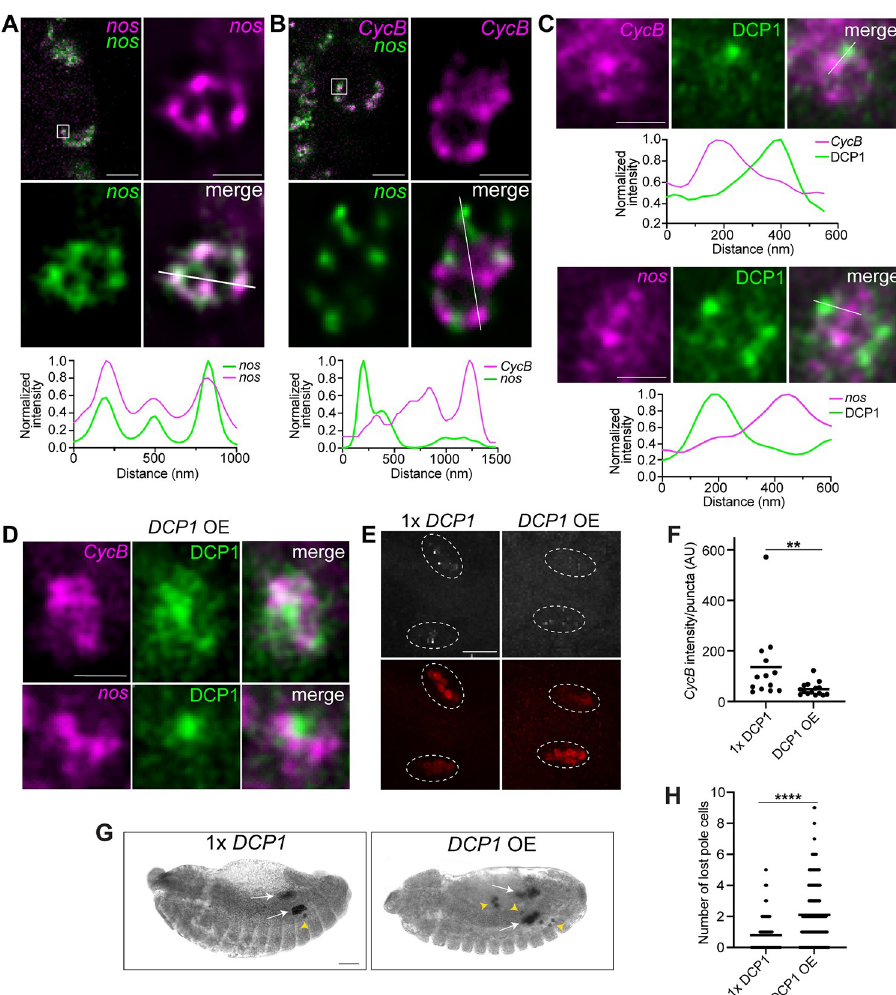
Fig 5. DCP1 localizes to puncta within germ granules that do not overlap with CycB or nos . (A, B) The 2D STED images of individual germ granules (indicated by the white box on the confocal section shown in the upper left panels) from a pole cell at nc13 or 14: nos was detected using 2 different smFISH probe sets (green + magenta) in (A); nos (green) and CycB (magenta) were detected by smFISH in (B). Fluorescence intensity was measured along the path marked with a white line and intensity profiles of each channel, normalized to the maximum value, are plotted. (C) The 2D STED images of individual germ granules showing the distribution of DCP1 (green) relative to nos or CycB (magenta) in wild-type embryos. Fluorescence intensity profiles along the path indicated by the white lines are shown. (D) The 2D STED images of individual germ granules showing the distribution of DCP1 (green) relative to nos or CycB (magenta) in embryos overexpressing DCP1-smg3 0 UTR . In all images, DCP1 was detected by immunofluorescence. STED images were deconvolved using NIS-Elements software and the brightness and contrast were adjusted individually for each image in order to best show the distributions of the mRNAs or protein at that stage. (E) Maximum intensity confocal z-projections of CycB detected by smFISH (white), and Vas detected by anti-Vas immunofluorescence (red) in the gonads of embryos heterozygous for a DCP1 mutation (1 × DCP1 ) and DCP1-smg3 0 UTR overexpression ( DCP1 OE) embryos. White circles outline the regions of the gonads. (F) The average fluorescence intensity of CycB puncta per embryo was quantified using Imaris, n = 13–15 embryos per genotype. (G) DIC images of representative 1 × DCP1 and DCP1 OE embryos. Pole cells were detected by anti-Vas immunohistochemistry. The gonads (white arrows) and lost pole cells (yellow arrow heads) are indicated. (H) Quantification of the number of lost pole cells per embryo at or after Bownes stage 14 from experiment in (G), n = 73– 223 embryos per genotype. Individual data points and mean values are shown. ** p < 0.01, **** p < 0.0001 according to Mann–Whitney test. Scale bars: 5 μ m for confocal images, 500 nm for STED images (A–D); 50 μ m (E, G). Source data for the graphs Fig 5A–5C, 5F and 5H are provided in S1 Data. smFISH, single-molecule fluorescence in situ hybridization; STED, stimulated emission